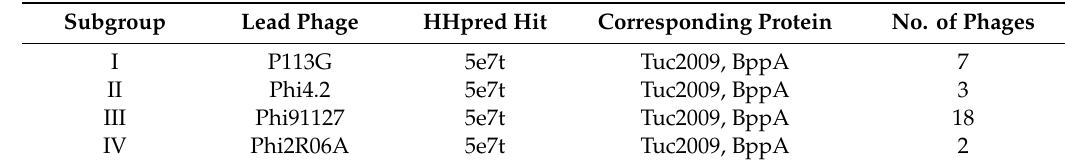
Figure 4. Sequence alignment and predicted structure for the tail protein extensions (TpeX) of 936 group phages. ( a ) Sequence alignment of the TpeX of representative phages highlighting homology to the BppA domain of Tuc2009. The conserved amino acids are in red and the partially conserved in blue. Otherwise in black. Performed with Multalin. ( b ) Structure of BppA CBM and junction domains, which is predicted to be highly similar to the structure of the TpeX. The CBM domain is highlighted in blue, while the junction region, which attaches the CBM domain to the tail tube, is highlighted in red, with the corresponding amino acid sequence also highlighted in ( a ). Table 2. TpeX extension subgroups as determined by HHpred analysis.